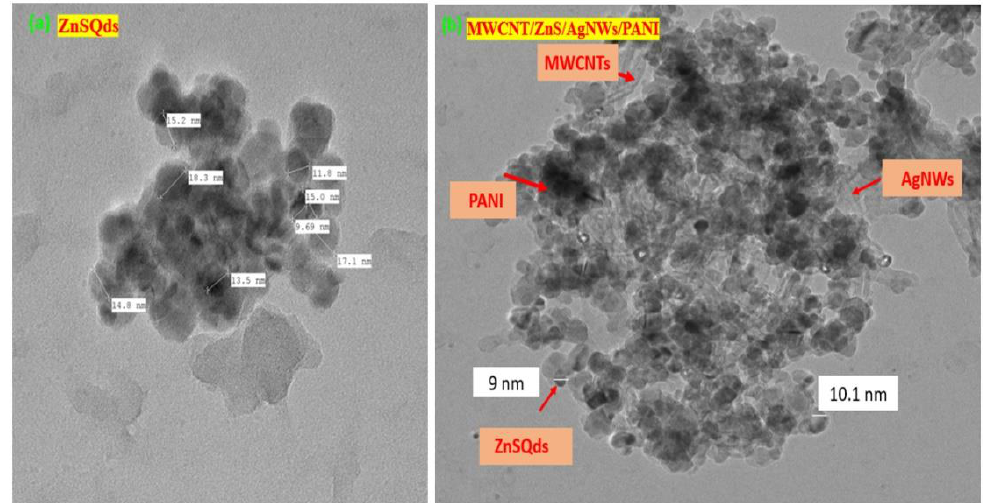
Figure 7. TEM images of: ( a ) ZnS Qds; ( b ) (MWCNT/ZnS/AgNWs/PANI) nanocomposite.